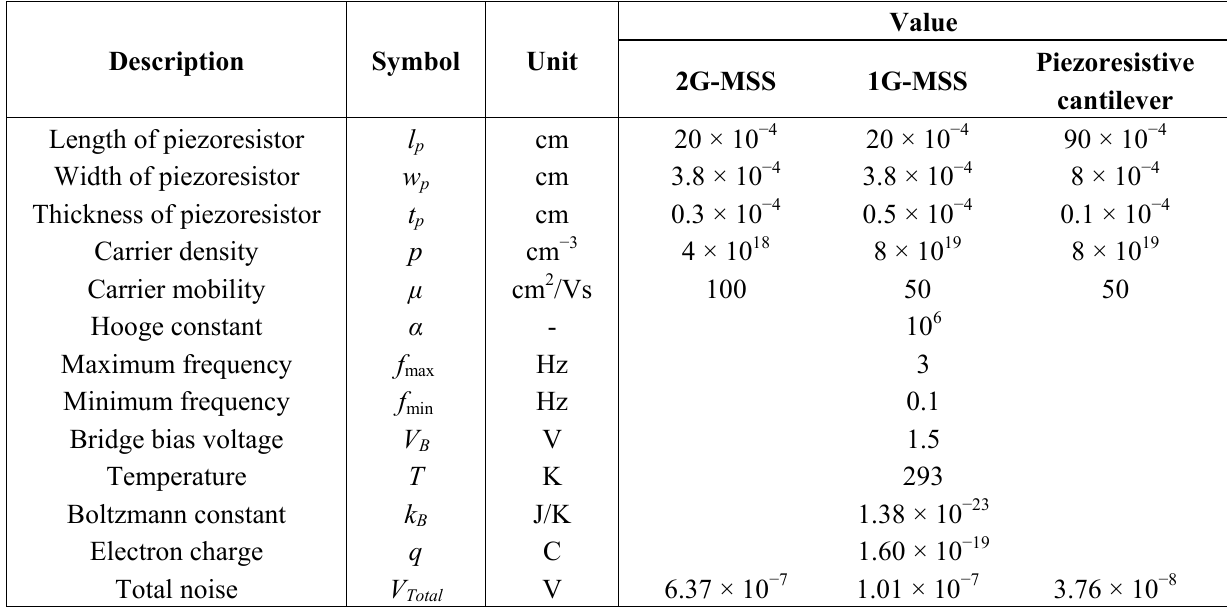
Table 2. Summary of the descriptions and values of the constants related to the intrinsic noises. The calculated total noises ( V ) for 2G-MSS, 1G-MSS, and the piezoresistive Total cantilever are given at the bottom row.